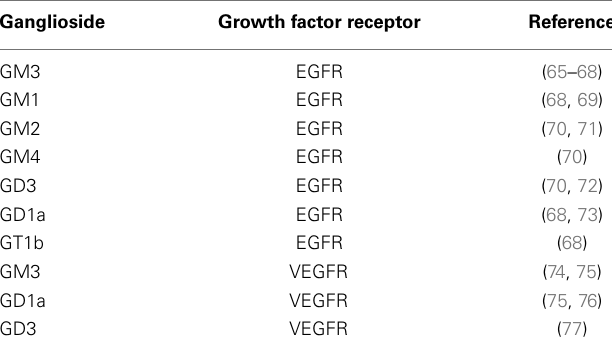
Table 1 | Gangliosides affecting the growth factor receptors EGFR and VEGFR